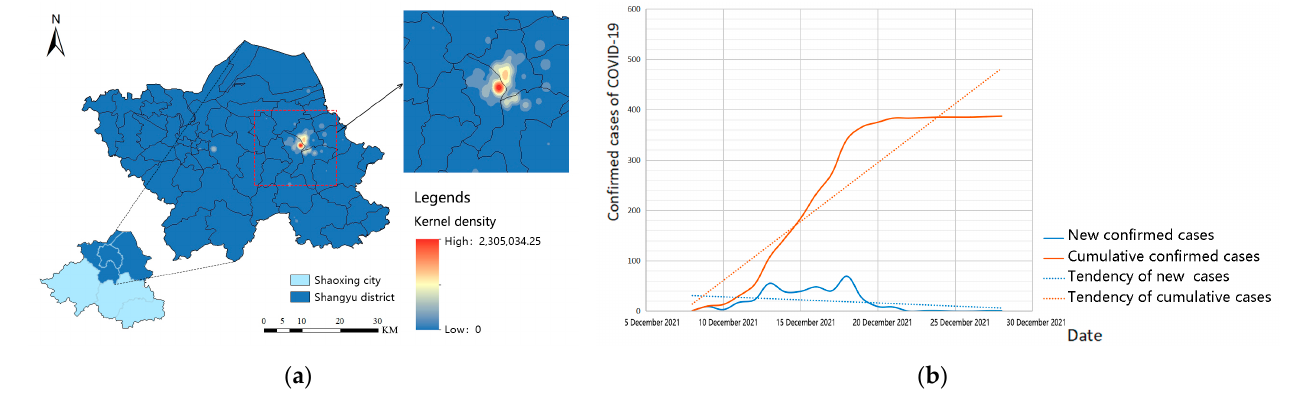
Figure 4. Spatial-temporal characteristics of confirmed COVID-19 cases in Shaoxing city: ( a ) Kernel- density analysis of confirmed COVID-19 cases; ( b ) Line chart of daily number of new and cumulative confirmed cases.